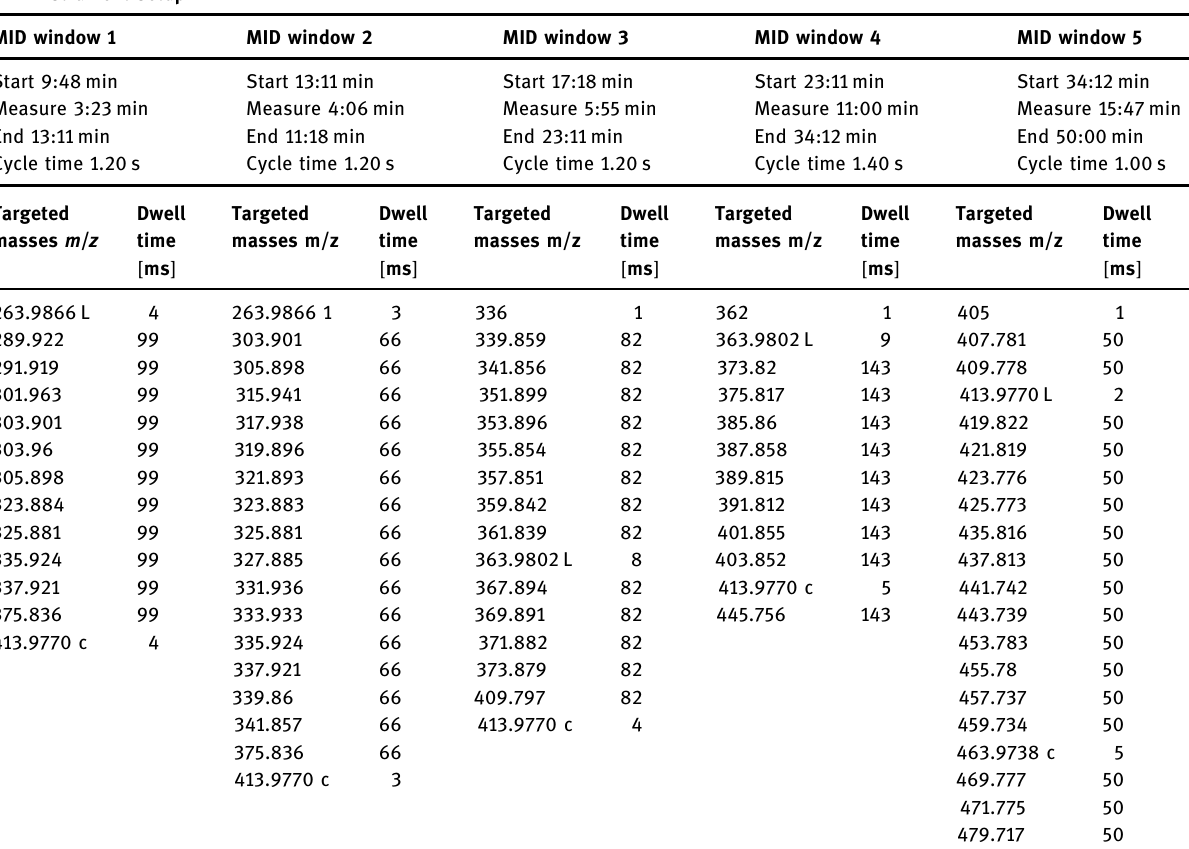
Table 2: MID for PCDD/F method procedure. MID instrument